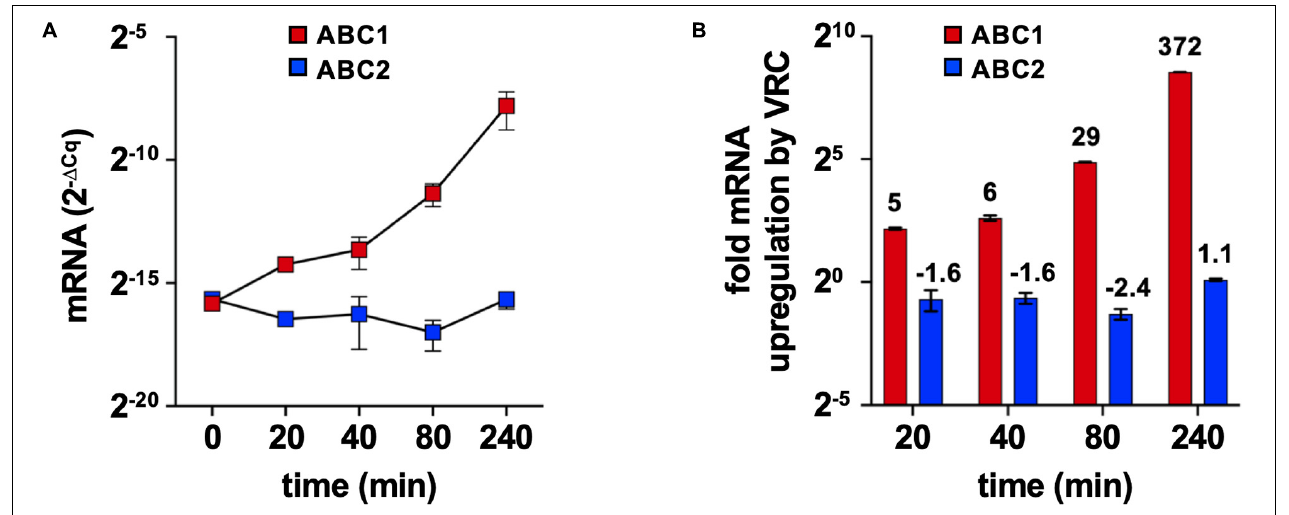
FIGURE 4 | F. keratoplasticum ABC1 and ABC2 mRNA expression levels in response to VRC exposure. Logarithmic phase F. keratoplasticum 2781 cells were incubated for 4 h at 30 ◦ C in PDB medium in the presence of sub-growth inhibitory concentrations of VRC (16 mg/L). (A) GAPDH normalised ABC1 and ABC2 mRNA expression levels (2 − (cid:49) Cq ) of F. keratoplasticum 2781 cells harvested at the indicated times of VRC induction (16 mg/L). (B) Graph of the fold up- or down-regulation of GAPDH normalised ABC1 and ABC2 mRNA expression levels after 20, 40, 80, and 240 min VRC exposure relative to their mRNA expression levels at time zero. Numbers on the top of each bar indicate the fold changes.